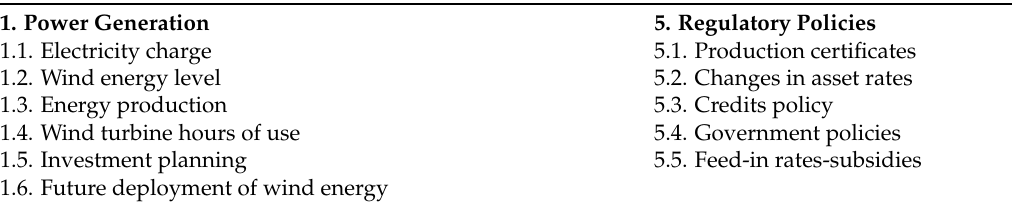
Table 4. Types of uncertainties explored in research with a real options